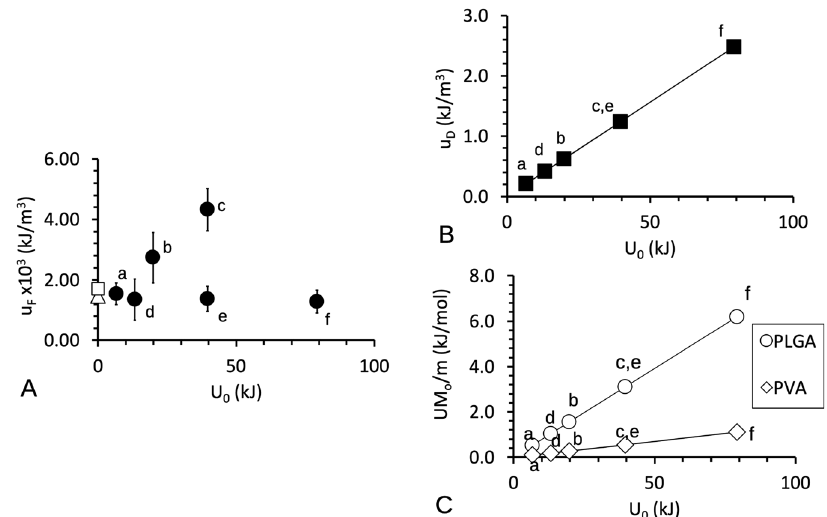
Fig. 9 Predictions of the sonication energy absorbed by the PLGA and PVA in the scaffold. Graphs of ( A ) mean scaffold fracture toughness (u F ), ( B ) predicted strain energy density (u D ) absorbed by the scaffold to dislodge PVA, and ( C ) predicted energy per mole (UM o /m) imparted to the PVA and PLGA polymers, versus the energy generated by the ultrasonic machine at source, U 0 . The values of u F were derived from Table 2; the error bars represent standard deviation. In ( A ), the two data points (unshaded circle □ and diamond Δ ) at U 0 = 0